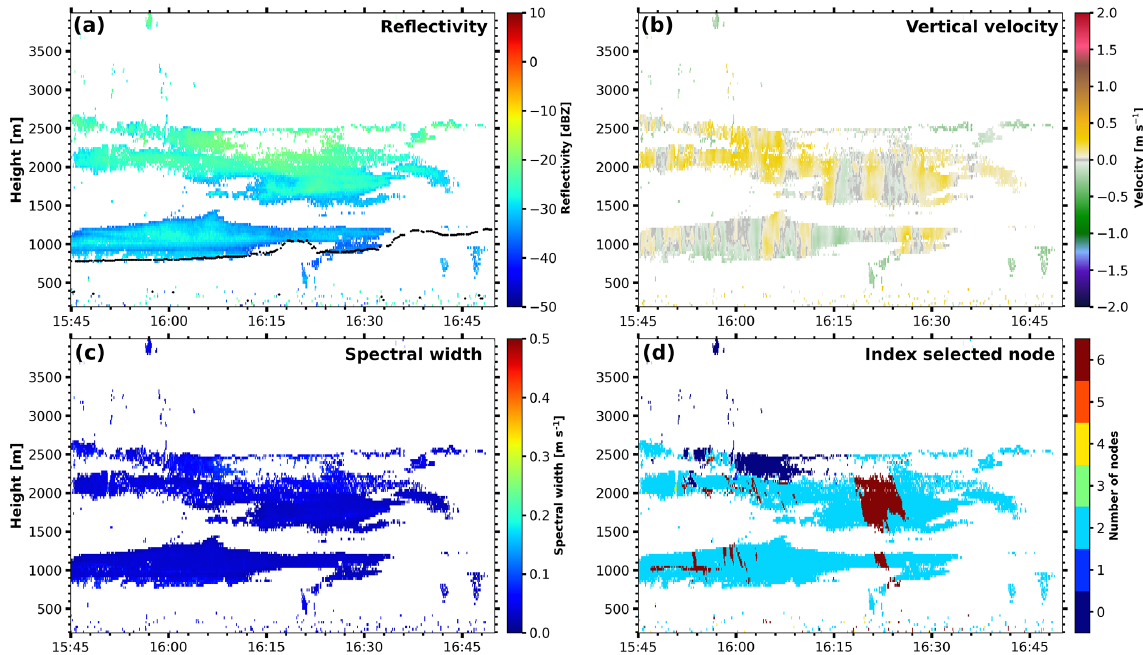
Figure 5. KAZR reflectivity with lidar-detected cloud-base height (black dots, a ), mean velocity (b) , spectral width (c) and index of node (d) for nodes identified as liquid cloud drops on 2 February 2014 from 15:45 to 16:45UTC.